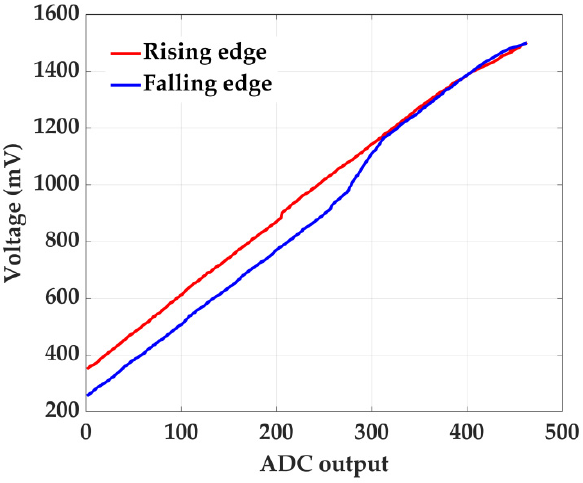
Figure 10. Voltage characteristic of rising and falling slope.